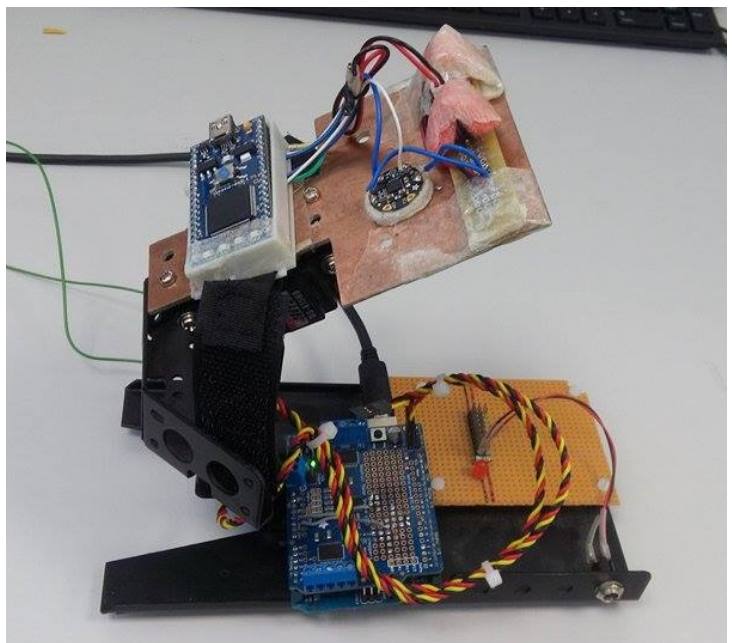
Figure 5. Orientation dynamic accuracy test setup.